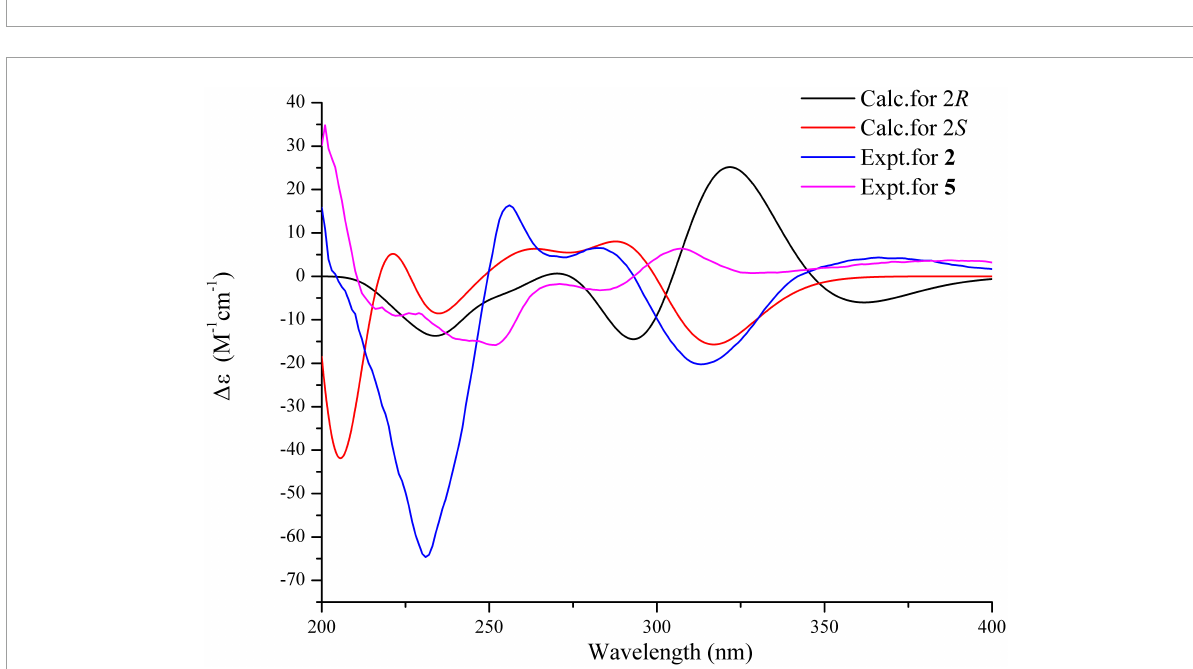
FIGURE4 Comparisons of experimental CD (MeOH) spectra between compounds 1–4.